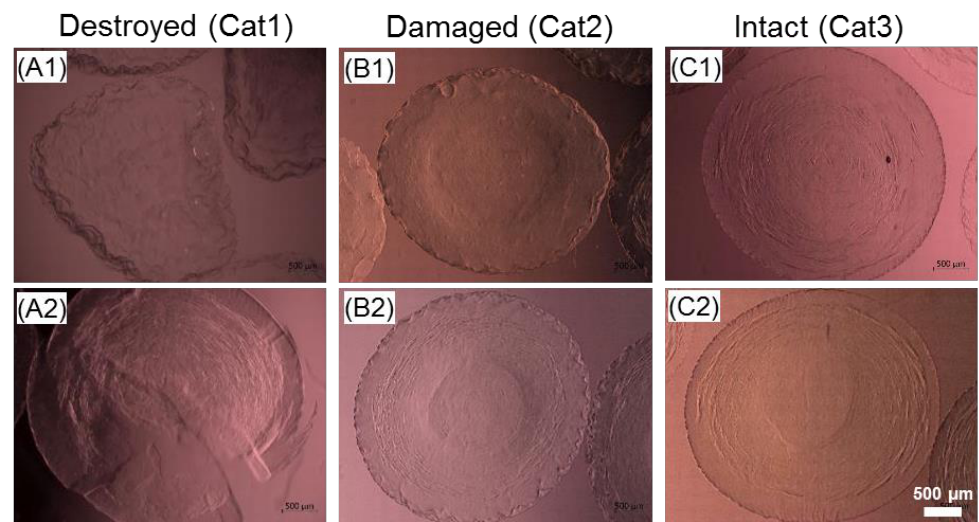
Figure 13. Gradation of damaging effects of core-shell capsules after thawing. ( A ) Destroyed capsules include ( A1 ) a shrunken sample with the completely lost shape and ( A2 ) a sample with completely disintegrated membrane. ( B ) Core-shell capsules with moderately ( B1 ) and severely damaged membranes ( B2 ). ( C ) Intact core-shell capsules possessing an intact outer layer, minor membrane damage, hardly visible ( C1 ) and good visible ( C2 ) core. Scale bars are 500 µm.